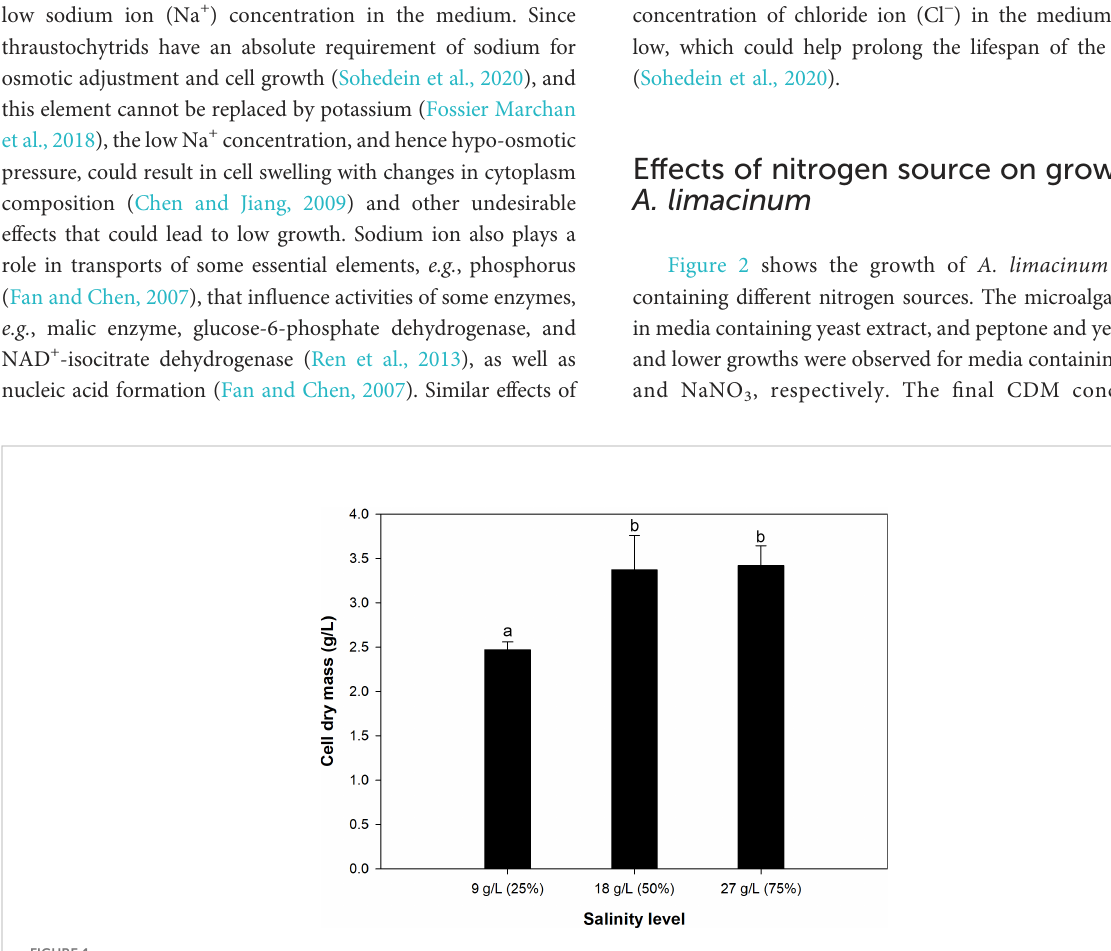
FIGURE 1 Growth of A. limacinum SR21 in 790 By+ media with 25%, 50% and 75% salinity levels. Different alphabets indicate statistically difference among the results at 95% con fi dence